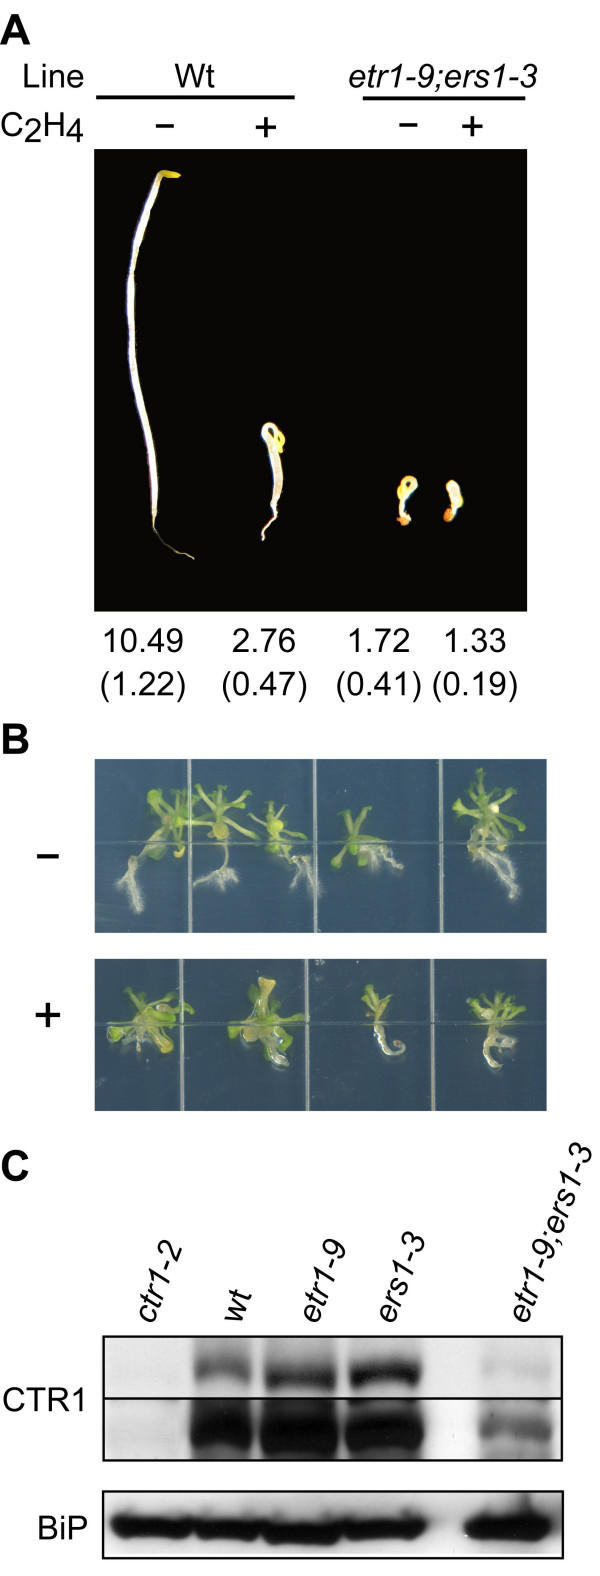
Ethylene response of the etr1-9;ers1-3 double mutant. (A) Effect of ethylene (10 μL/L) upon 4-day-old dark-grown seedlings (based on >20 seedlings per treatment). Mean hypocotyl lengths are given in millimeters with SD in parentheses. AVG (5 μM) was included in growth media to inhibit ethylene biosynthesis by the seedlings. (B) Effect of 50 μM ACC upon root and shoot growth of light-grown seedlings. Seedlings are 25-days old, the ACC treatment for 18 days. (C) Levels of CTR1 associated with microsomes based on immunoblot analysis. Two exposures of the CTR1 blot are shown. BiP is included as a loading control.